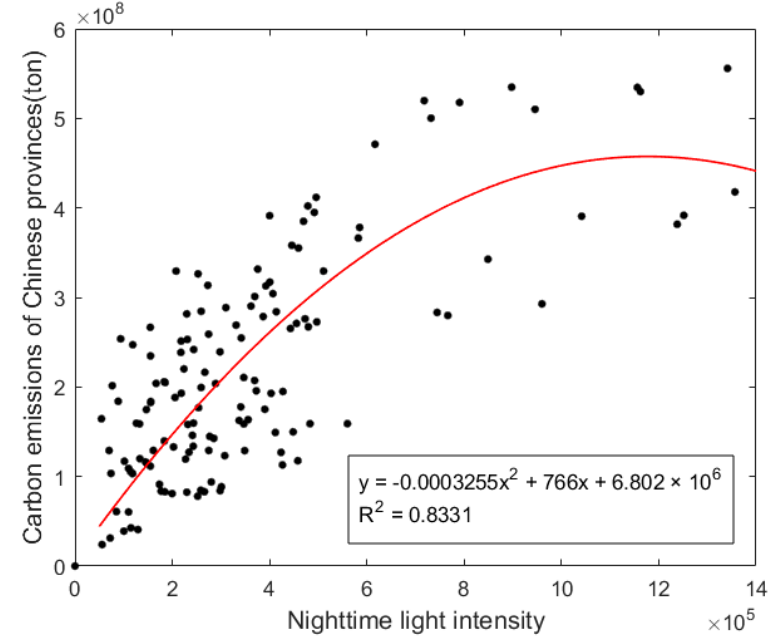
Figure 5. Fitting relationship between NL data and carbon emission data of Chinese provinces. In Figure 5, the dots represent Chinese provinces. Tibet, Hong Kong, Macao, and Taiwan were excluded from the study due to the lack of complete information. The abscissa is NL intensity and the ordinate is carbon emissions. Due to excessive data, only odd-year data are used in Figure 5. NL data adopt the total intensity of regional light, i.e., the sum of DN values of all pixels in a province in China. Carbon emission data are also the total carbon emissions of each province. It can be seen from Figure 5 that there is a positive correlation between NL data and carbon emission data. Places with large DN values of NL light have frequent social and economic activities, leading to an increase in carbon emissions. This is also consistent with the existing carbon emission estimation model, that is, NL data as the input are considered to have a positive correlation with carbon emissions [29]. Moreover, Figure 6 is a statistical chart of the total DN value of annual nighttime light and the total carbon emission of Beijing from 2008 to 2017. Comparing the long-term series NL data with the carbon emission data, we can find that the results basically satisfy that, when the nighttime light intensity is high, the carbon emissions rise. Besides, when the intensity is low, the carbon emissions are also reduced, which verifies the positive correlation between NL data and carbon emissions and further validates the conclusions of current